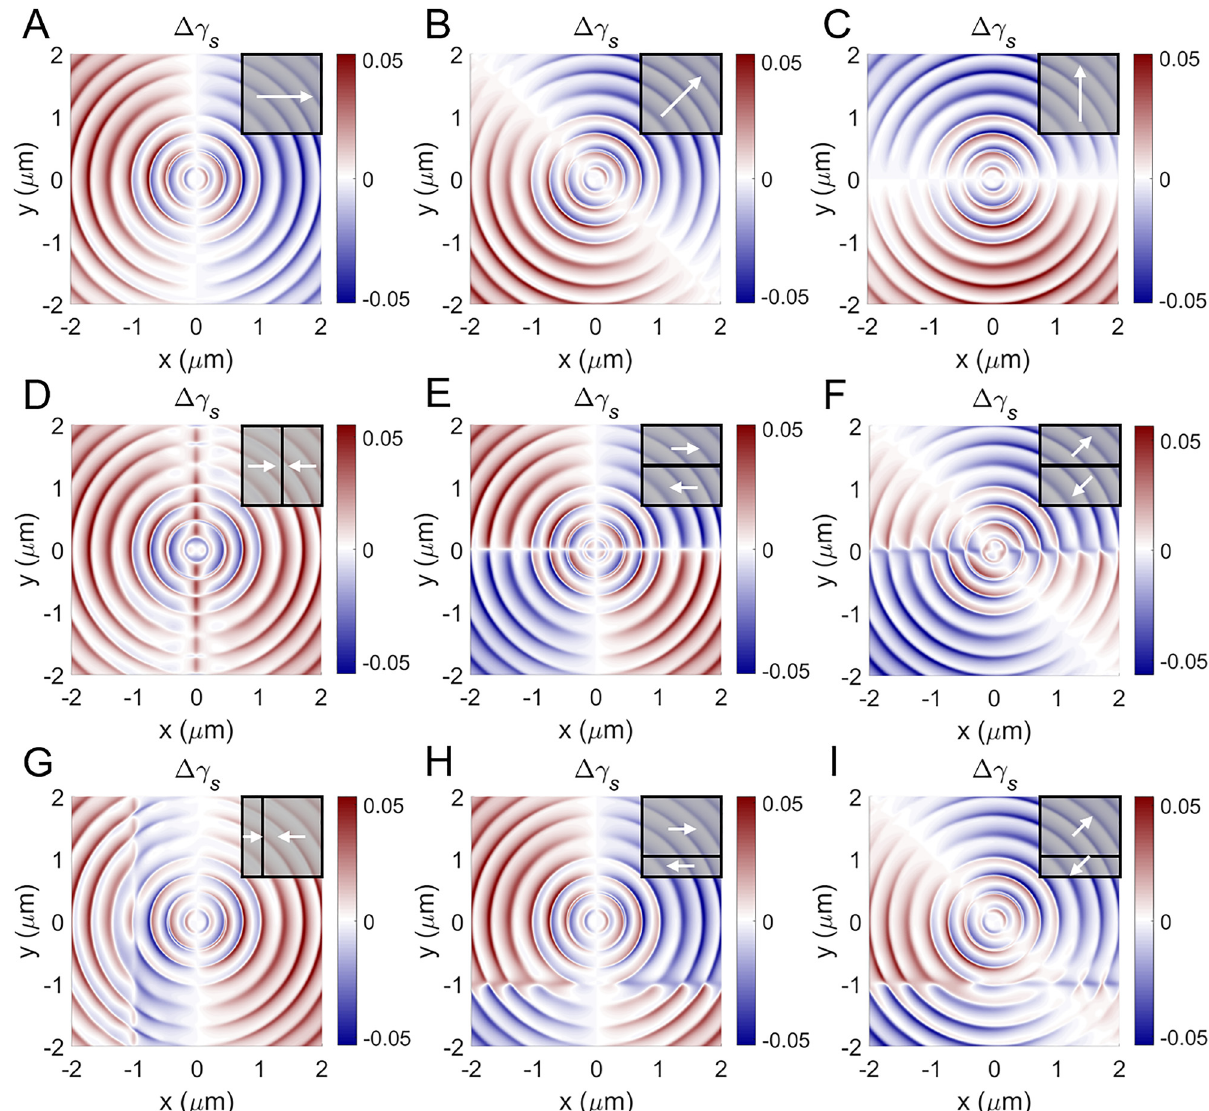
Figure 4: (A – C)Simulateddistributionsof Δ γ s fordifferent magnetizationorientations intheplaneof the fi lm( xy plane):(A) φ 0 =0,(B) φ 0 = π /4, (C) φ 0 = π /2. (D – I)The sameas(A – C)for thedomainstructure withthedomain walllocated at (D) x = 0,(E – F) y = 0,(G) x = − 1 μ m,(H,I) y = − 1 μ